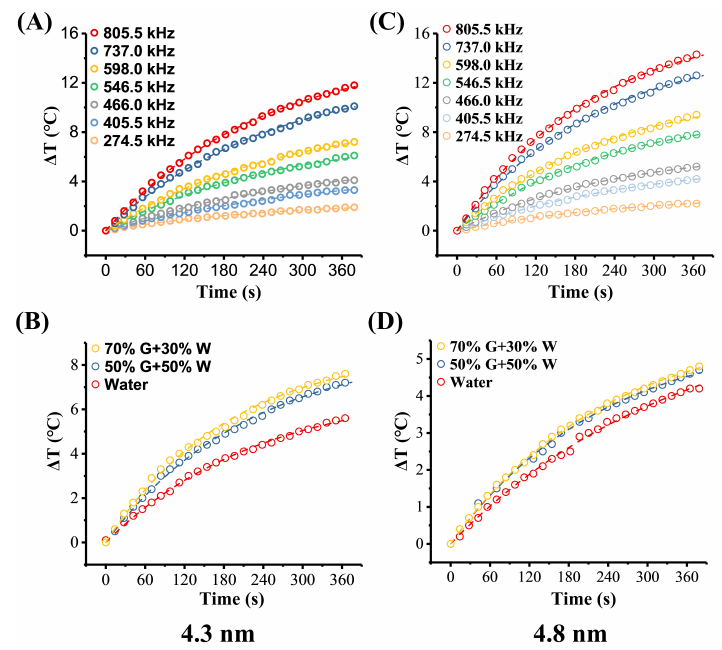
Figure 9. E ff ects of magnetic field frequency and viscosity on heating e ffi ciency of 4.3 nm ( A , B ) and 4.8 nm ( C , D ) samples. Dependence of AMF frequency on heating e ffi ciency of ( A ) 4.3 nm and ( C ) 4.8 nm MHFn nanoparticles with concentration of 5 mg[Fe] / mL, measured at 19.5 kA / m. Temperature rise measurement in di ff erent glycerol-water mixture of ( B ) 4.3 nm sample at 2.5 mg[Fe] / mL and ( D ) 4.8 nm sample at 1.5 mg[Fe] / mL performed at magnetic field H = 19.5 kA / m and f = 805.5 kHz. Dotted lines are the fitting results of Box-Lucas